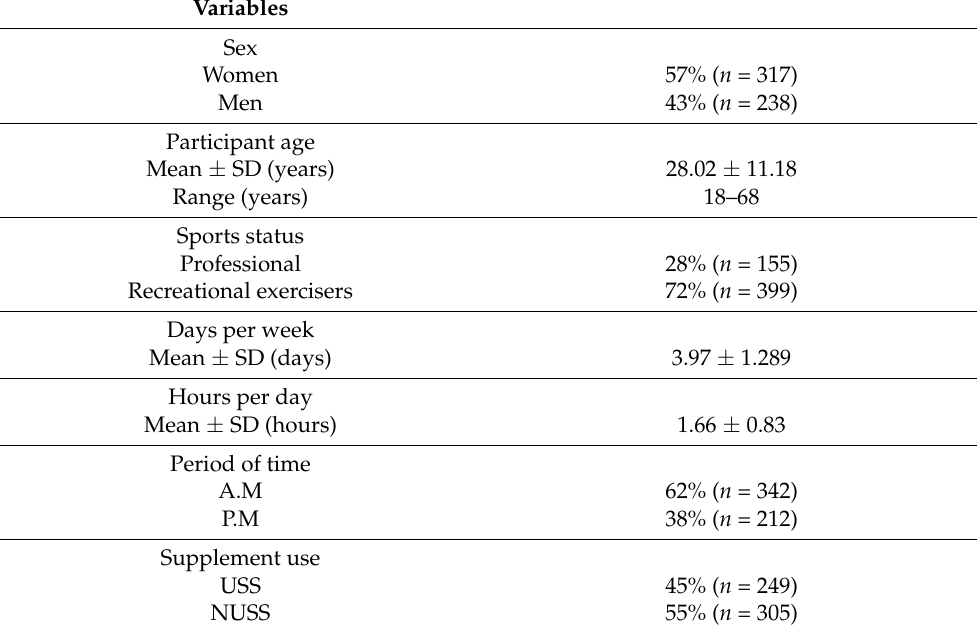
Table 1. Descriptive characteristics of the sample population ( N =